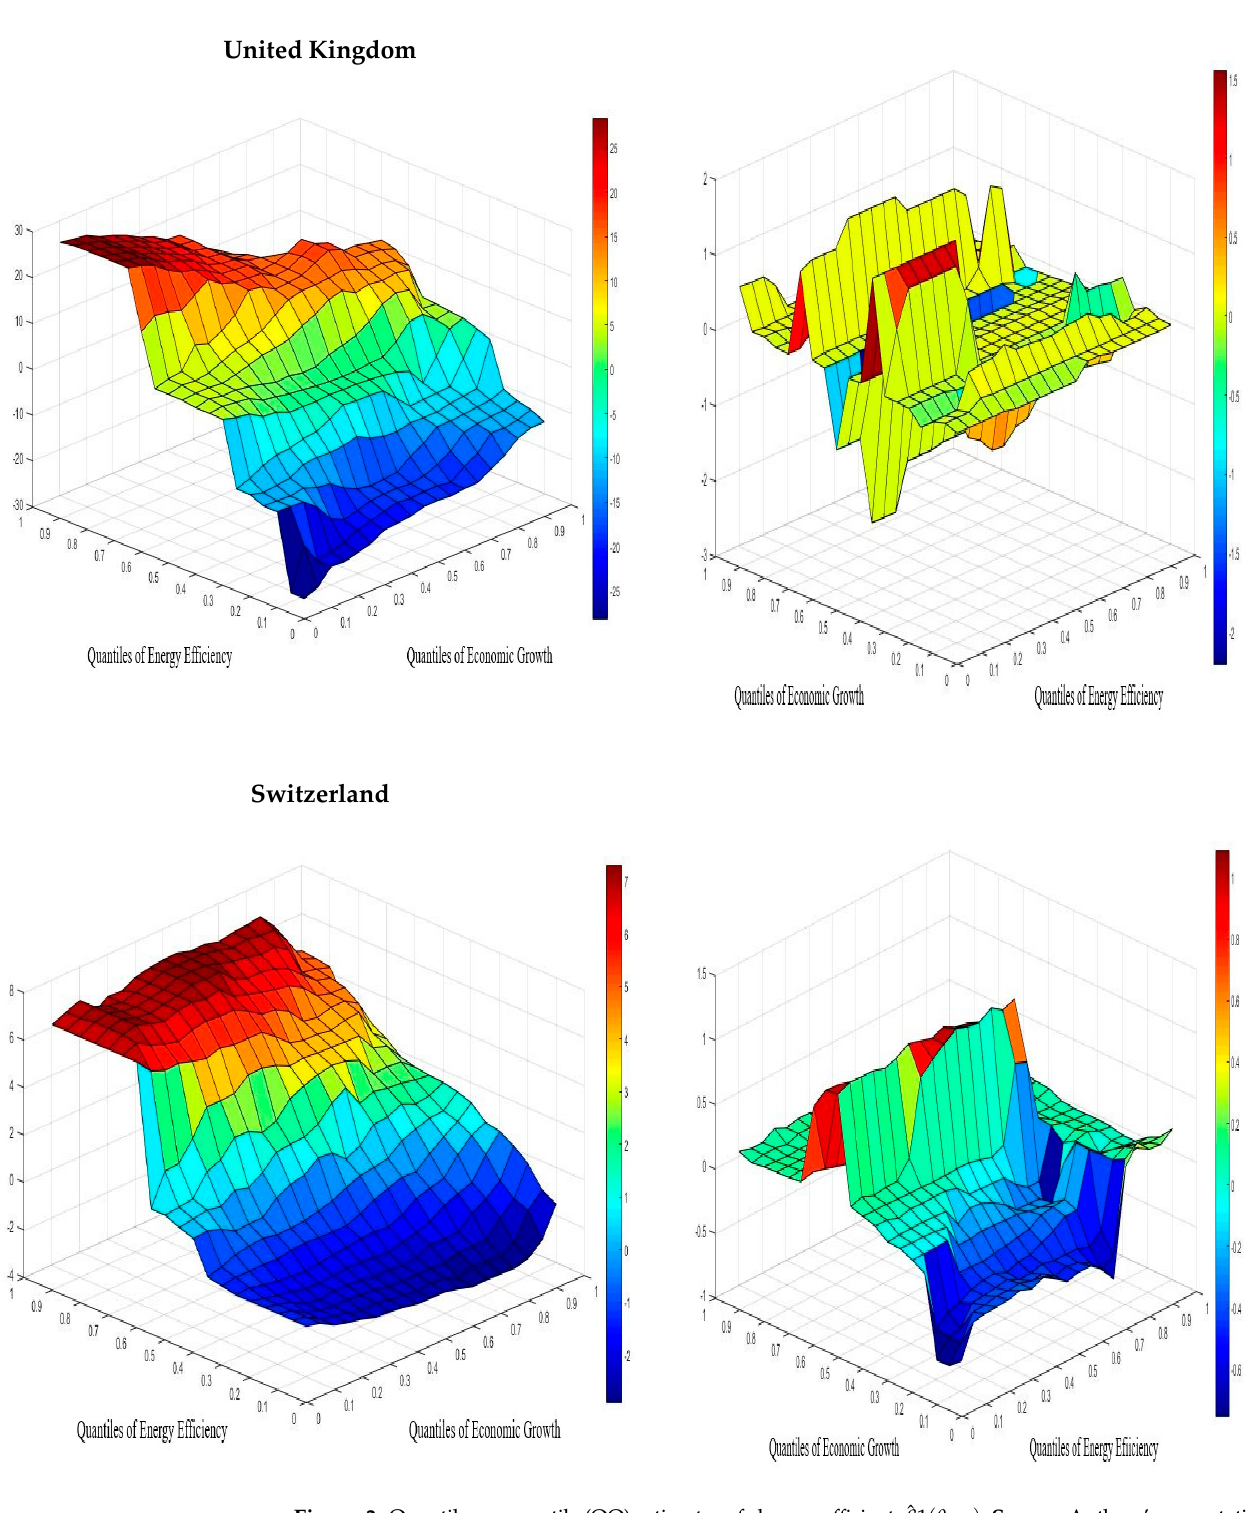
Figure 3. Quantile-on-quantile (QQ) estimates of slope coefficient, 𝛽(cid:4632)1(𝜃, 𝜏) . Source : Authors’ com- putation.